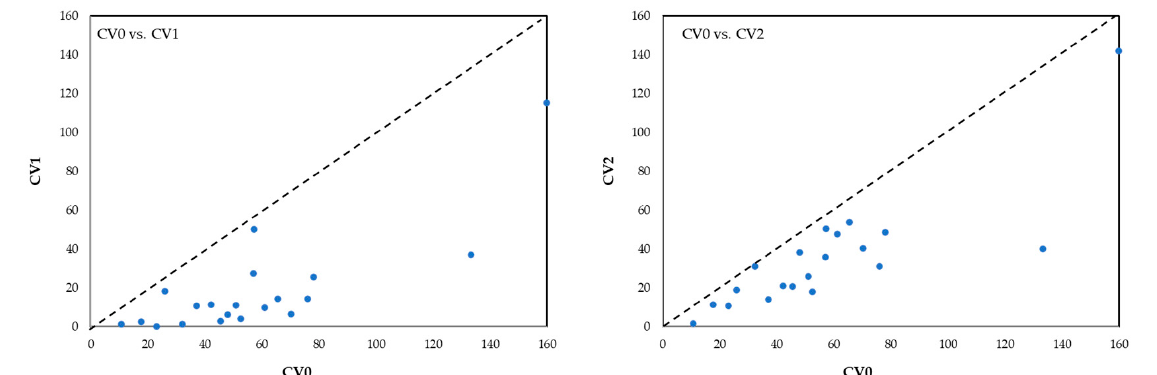
Figure 6. Plots between the CV0 and higher order CVs of landings of the high and high-medium vulnerability taxa from the trawl fisheries in the Gulf of Thailand.